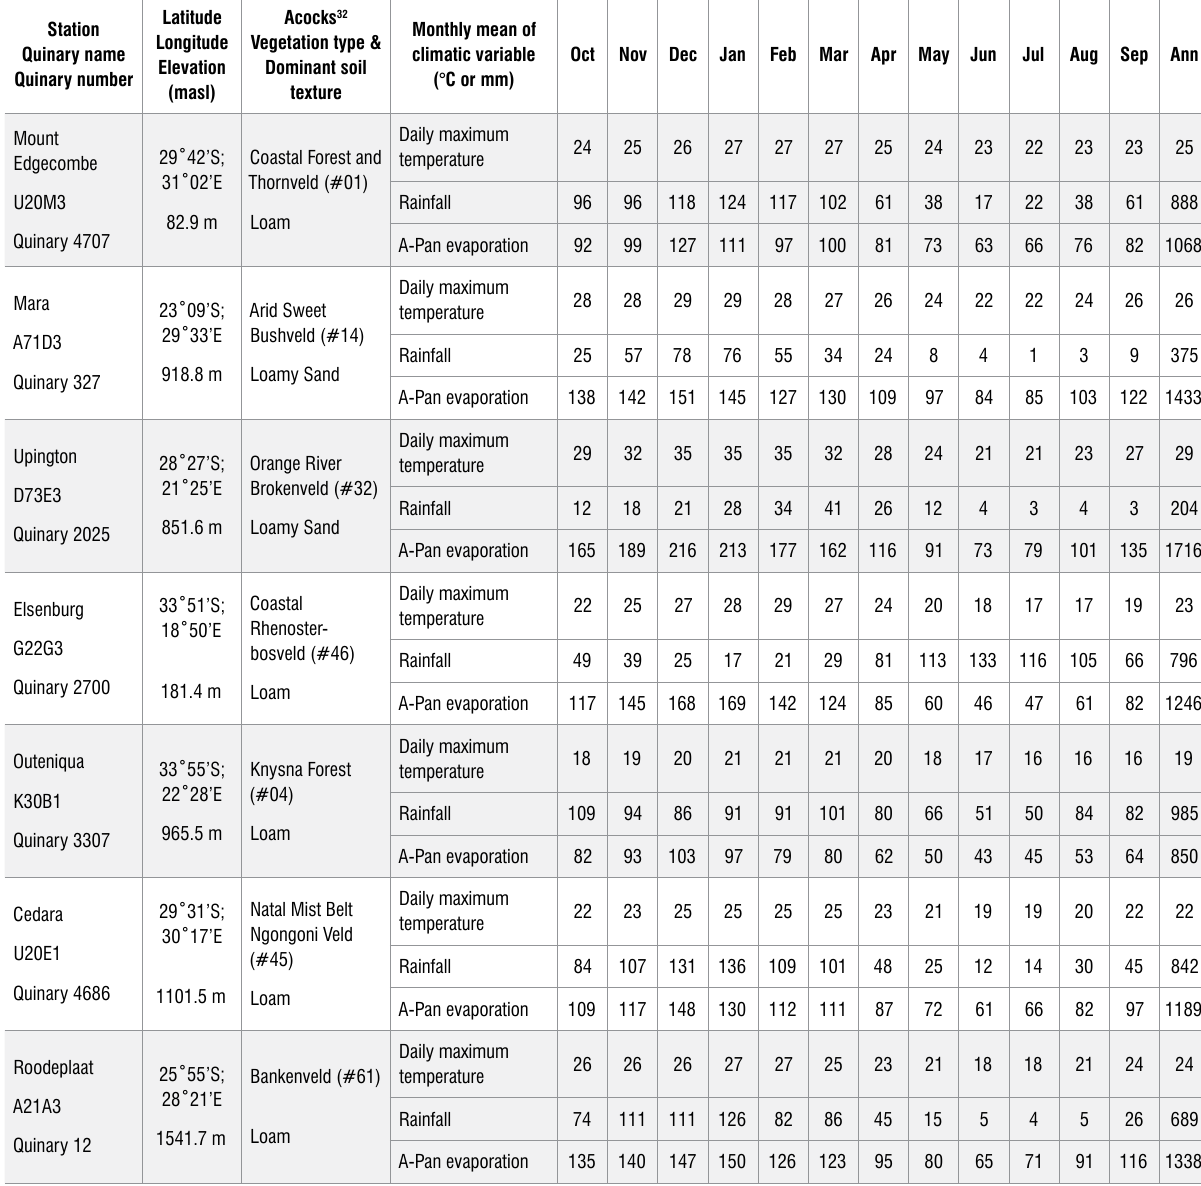
Selected stations, their locations, their representative Quinary catchment and characteristics, monthly means of daily maximum temperature (°C), monthly rainfall (mm) and of A-Pan equivalent evaporation totals (mm) for the period 1950–1999 for the seven hydroclimatic zones, after Hughes